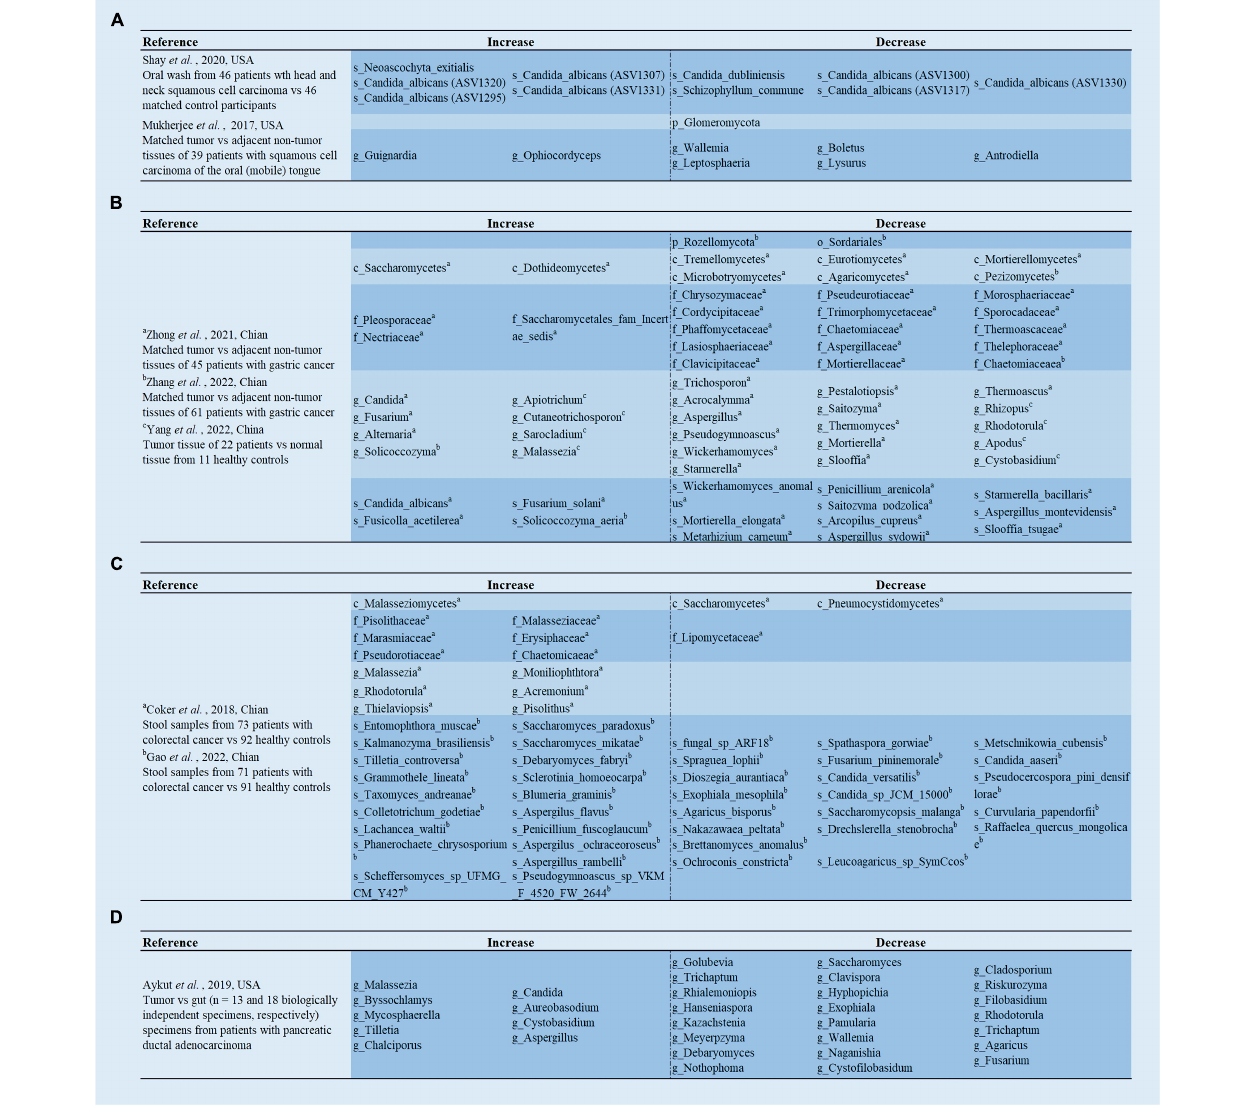
FIGURE 1 | Analysis of the differences in gut mycobiota. (A) Shay et al. (2020) demonstrated the differences of the mycobiome in the oral washings from patients with head and neck squamous cell carcinoma (HNSCC) compared to matched control participants; Mukherjee et al. (2017) revealed the differences of the mycobiome in the tumor tissues compared to adjacent non-tumor tissues from patients with oral squamous cell carcinoma OSCC (mobile) in the tongue. (B) Zhong et al. (2021) and Zhang et al. (2022) revealed the differences of the mycobiome in the tumor tissues compared to adjacent non-tumor tissues from patients with gastric cancer; Yang et al. (2022) revealed the differences of the mycobiome in the tumor tissues from patients with gastric cancer compared to normal tissue from healthy controls. (C) Coker et al. (2019) and Gao et al. (2022) revealed the differences of the mycobiome in the stool samples from patients with colorectal cancer compared to healthy controls. (D) Aykut et al. (2019) revealed the differences of the mycobiome in the tumor specimens compared to gut specimens from patients with pancreatic ductal